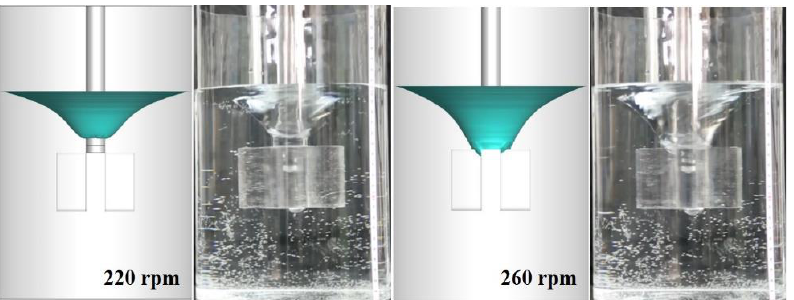
Figure 4. Comparison of vortex depth of numerical simulation and water model at impeller immer- sion depths of 100 mm and 120 mm.